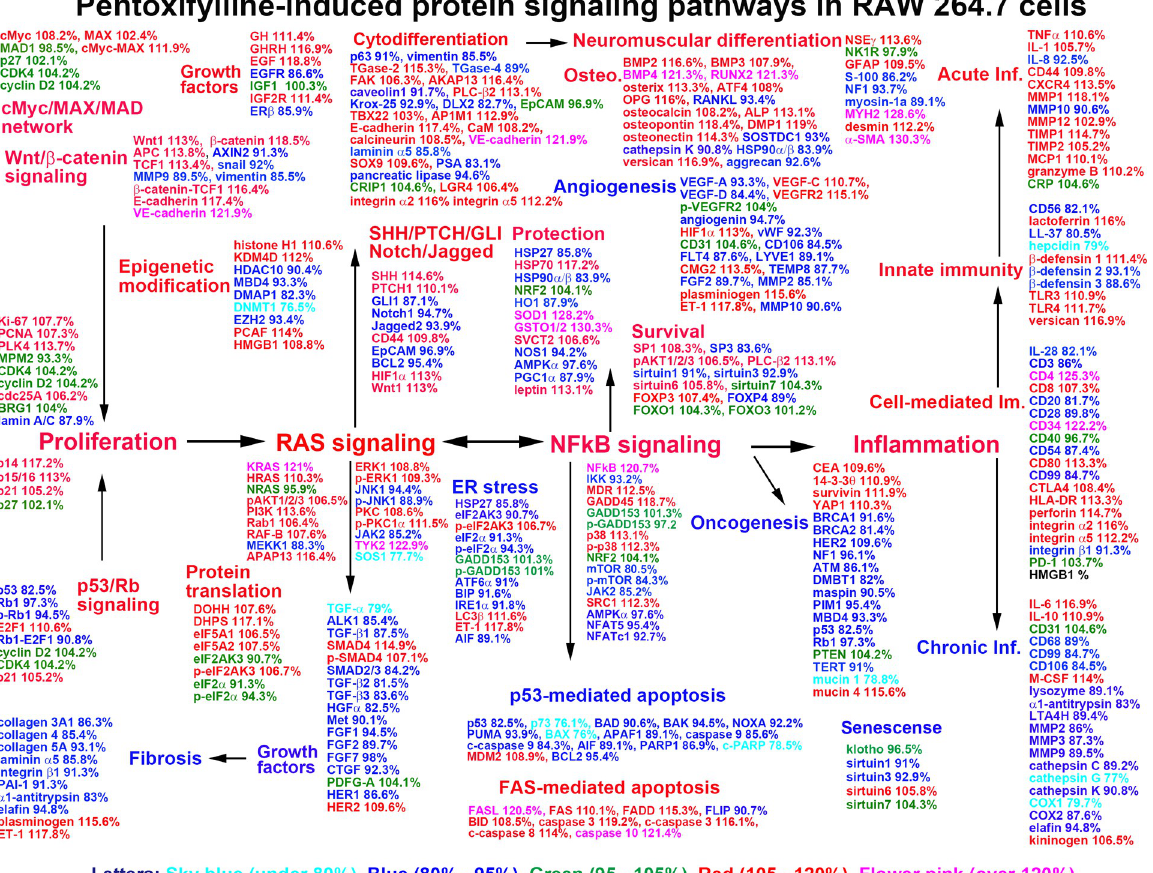
Fig 19. A diagram of 10 μ g/mL PTX-induced protein expression change in global protein signaling pathways of RAW 264.7 cells. The main axis of cellular signaling, that is, proliferation, RAS signaling, NFkB signaling, protection, survival and aging, and inflammation were consistently activated by 10 μ g/mL PTX, and subsequently followed by activation of epigenetic modification, protein translation, Wnt/ β -catenin, cMyc/MAX/ MAD network, neuromuscular and osteoblastic differentiation, acute inflammation, innate immunity, cell-mediated immunity, and FAS- mediated apoptosis, while inactivation of p53/Rb/E2F signaling, ER stress, angiogenesis, fibrosis, and chronic inflammation. Sky blue letter: downregulated expression (under 80%), Blue letter: downregulated expression (80–95%), Green letter: minimal change expression (95–105%), Red letter: upregulated expression (105–120%), Flower pink letter: upregulated expression (over 120%).